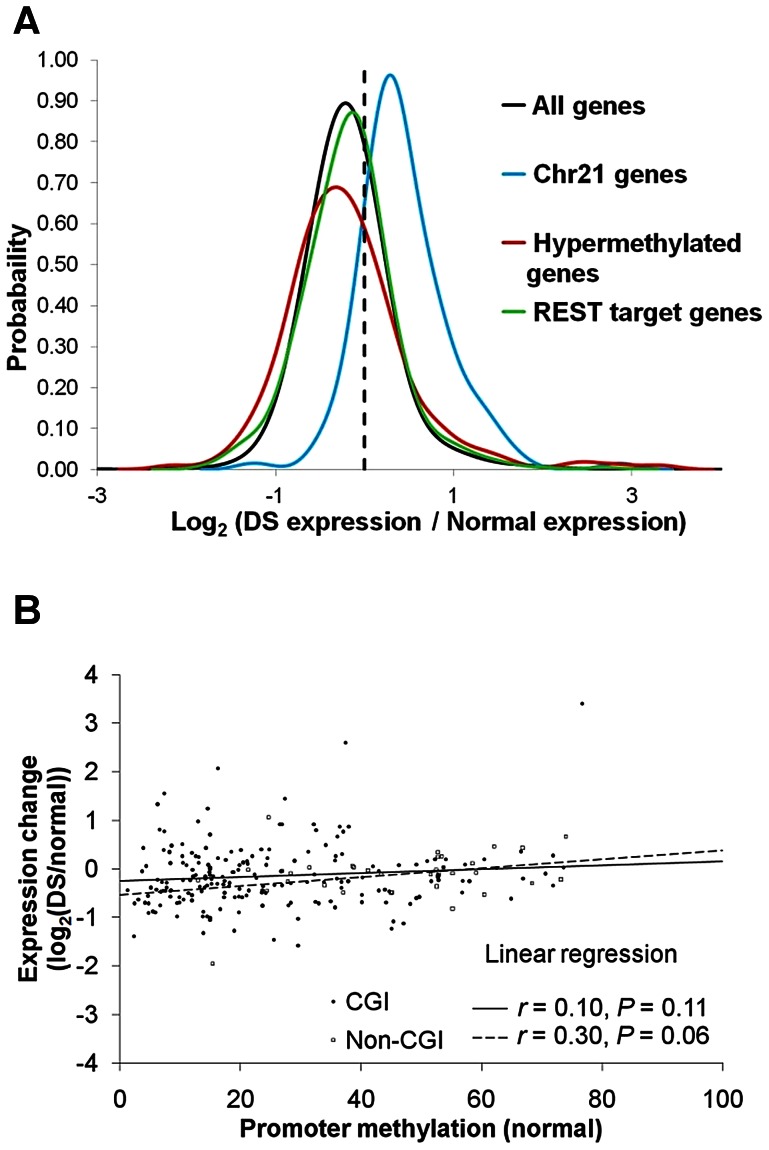
Gene expression changes in DS.For each gene, average expression values (RPKM) were calculated for both normal and DS samples. Only genes with RPKM ≥0.5 in at least one sample group were used for further analysis. Gene expression changes in DS were represented by log2 (Average DS samples expression/Average normal samples expression). (A) PDF distribution for gene expression changes for all genes, chr21 genes, hypermethylated genes and REST target genes. Genes located on chr21 were up-regulated by an average of 53% in DS. The hypermethylated genes were down-regulated, as evidenced by a left shift of the PDF curve (p<0.05, Wilcoxon rank-sum test, two-sided). The genes targeted by REST were marginally up-regulated (p = 0.06, Wilcoxon rank-sum test, two-sided). (B) Repression of gene expression by promoter hypermethylation was more prominent in promoters that were originally at lower methylation levels in normal samples. Each data point represents one hypermethylated promoter. X axis is the average methylation level in the normal samples for each promoter. Y axis is the gene expression ratio between DS and normal (log2 transformed).